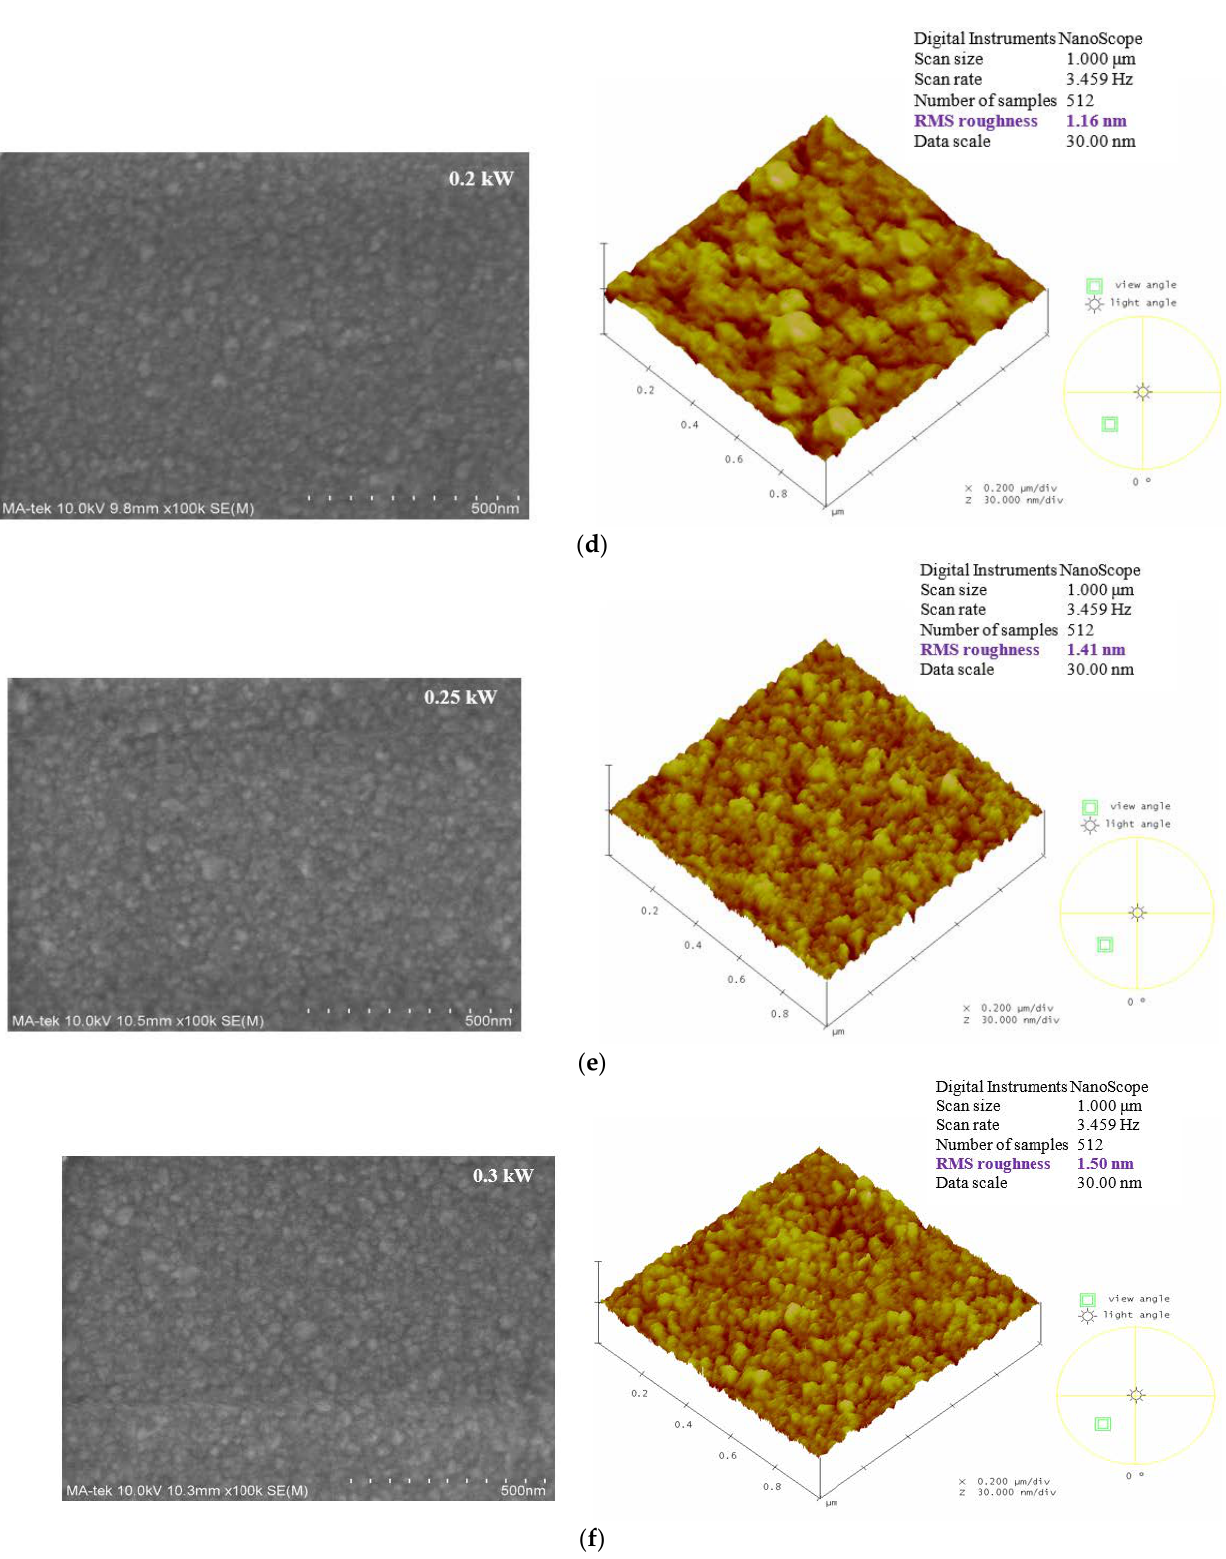
Figure 5. Surface FESEM and AFM images of the nano-Ag film on ITO layer with increasing Ag DC power ( a ) 0.05 kW, ( b ) 0.1 kW, ( c ) 0.15 kW, ( d ) 0.2 kW, ( e ) 0.25 kW, and ( f ) 0.3 kW. Using 1 × 1 μm 2 AFM scans of nano-Ag film on the ITO layer, the root mean square (RMS, R a ) roughness decreases smoothly first as the Ag DC power increases from 0.05 kW to 0.2 kW. Then, the R a -value increases when the Ag DC power is at 0.25 kW and 0.3 kW.